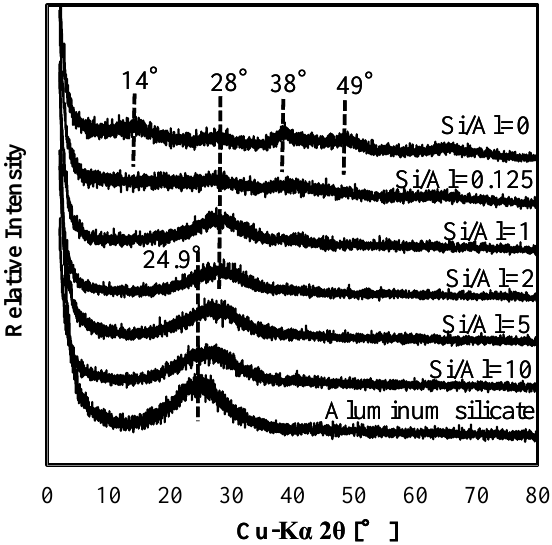
Figure 3. XRD spectra of silicate co-precipitated residues obtained at pH 9. The initial aluminum concentration was 1.48 mmol·dm −3 .